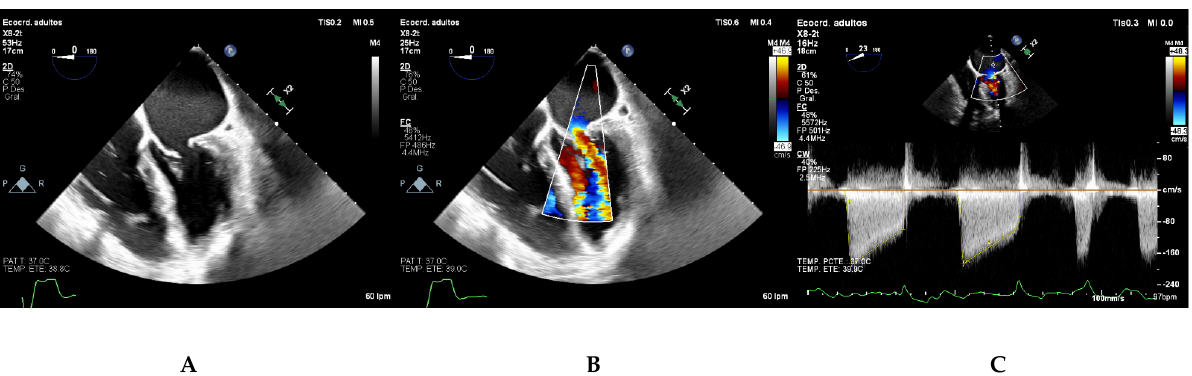
Figure 5. ( A ) Mid-esophageal four chamber view. ( B ) Color Doppler at the mitral valve level in a mid-esophageal four chamber view. ( C ) Continuous wave Doppler parallel to the mitral inflow in mid-esophageal four chamber view.